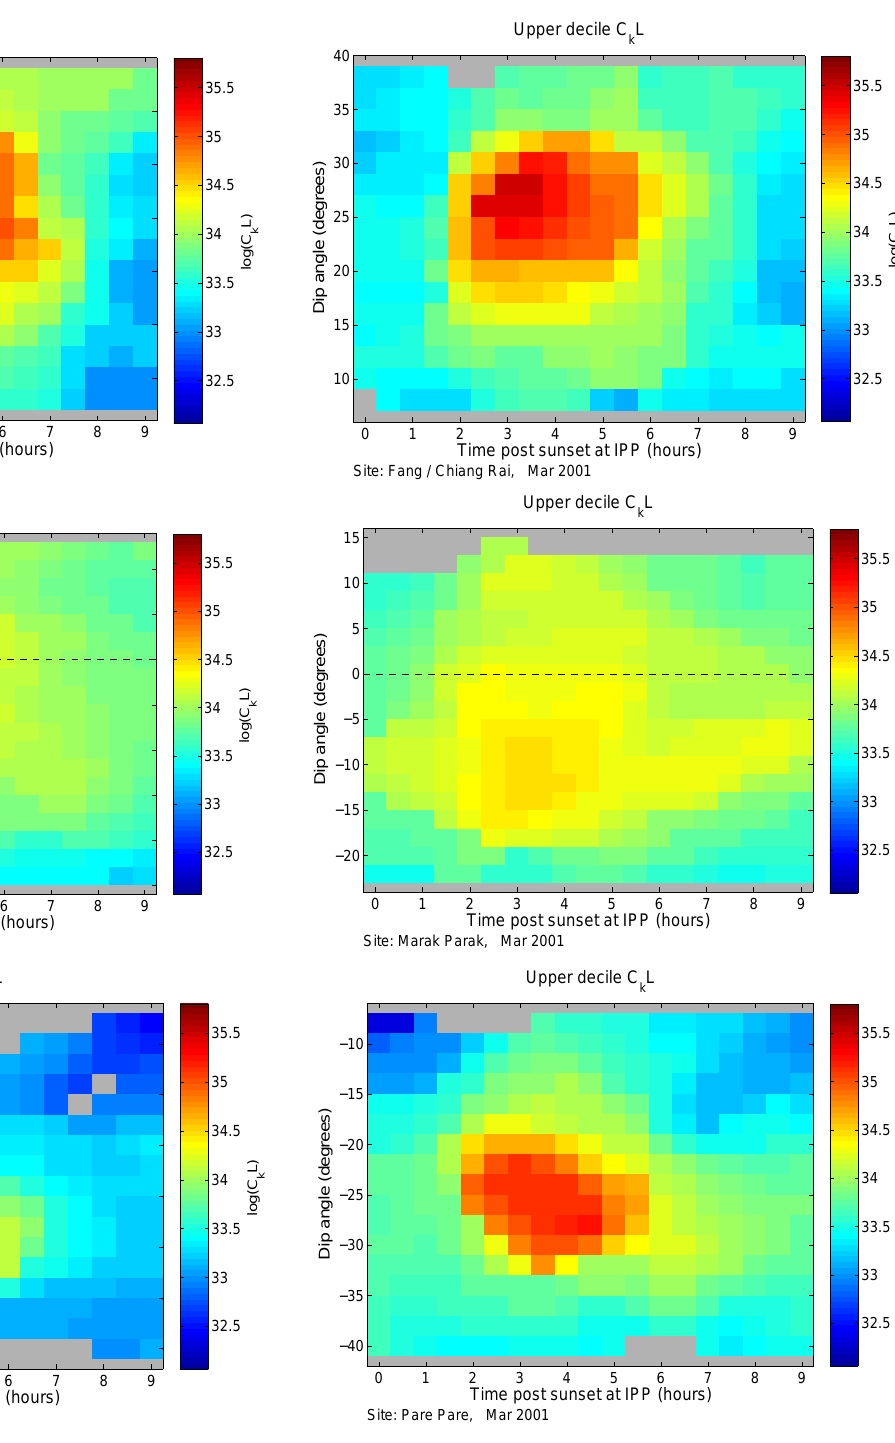
Fig. 5. Upper decile C k L , September 2000, at Chiang-Rai (top), Marak Parak (middle) and Pare Pare (bottom). The dashed line in- dicates the magnetic equator.